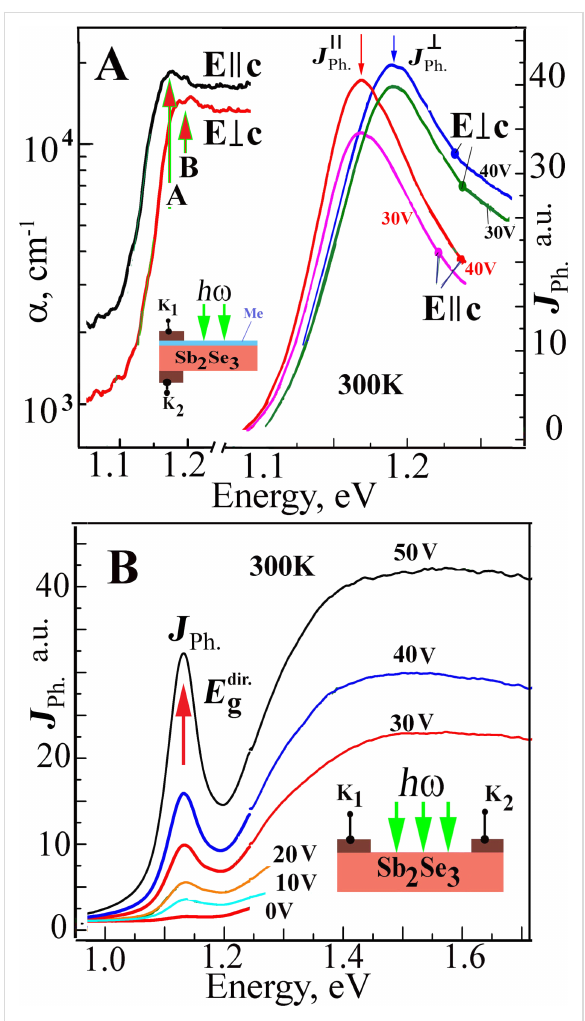
Figure 3: (A) The spectra showing the edge absorption ( α ) and photo- conductivity ( J Ph ) for the Sb 2 Se 3 crystals measured under E ||c and E ⟂ c polarization conditions and at room temperature (insert shows the structure used for the photoconductivity measurements). (B) The photoconductivity spectra measured at room temperature for various voltages applied to the In–Sb 2 Se 3 contact (insert illustrates this struc-